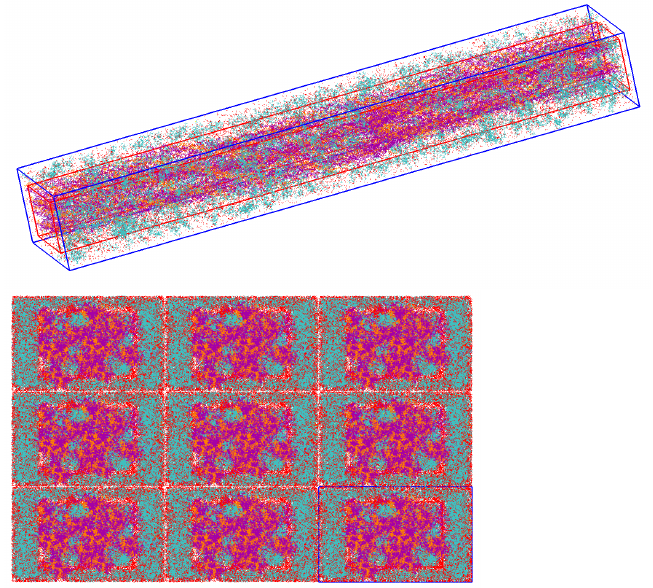
Figure 7. Simulation box of a Bone Fiber model, and a view of a 3-by-3 periodic replication of its xy-cross-section (VMD). HA, H 2 O, and CLG molecules are shown in cyan, red, and purple (alpha-1 chains) and orange colors (alpha-2 chains),